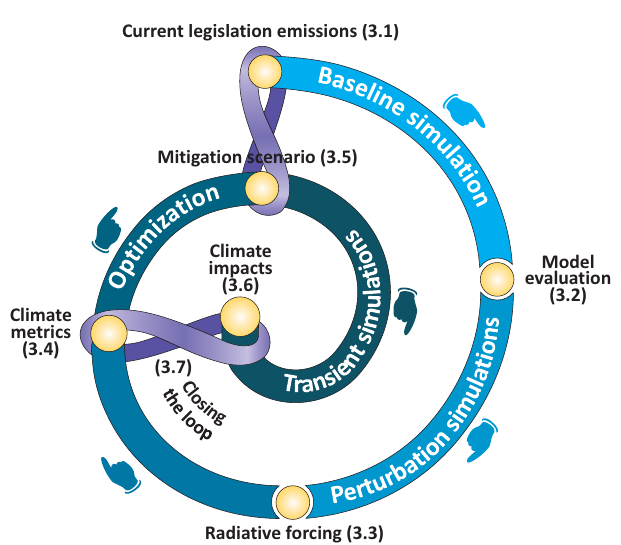
Figure 1. Schematic of the ECLIPSE overall methodology. Num- bers in brackets correspond to section numbers in this